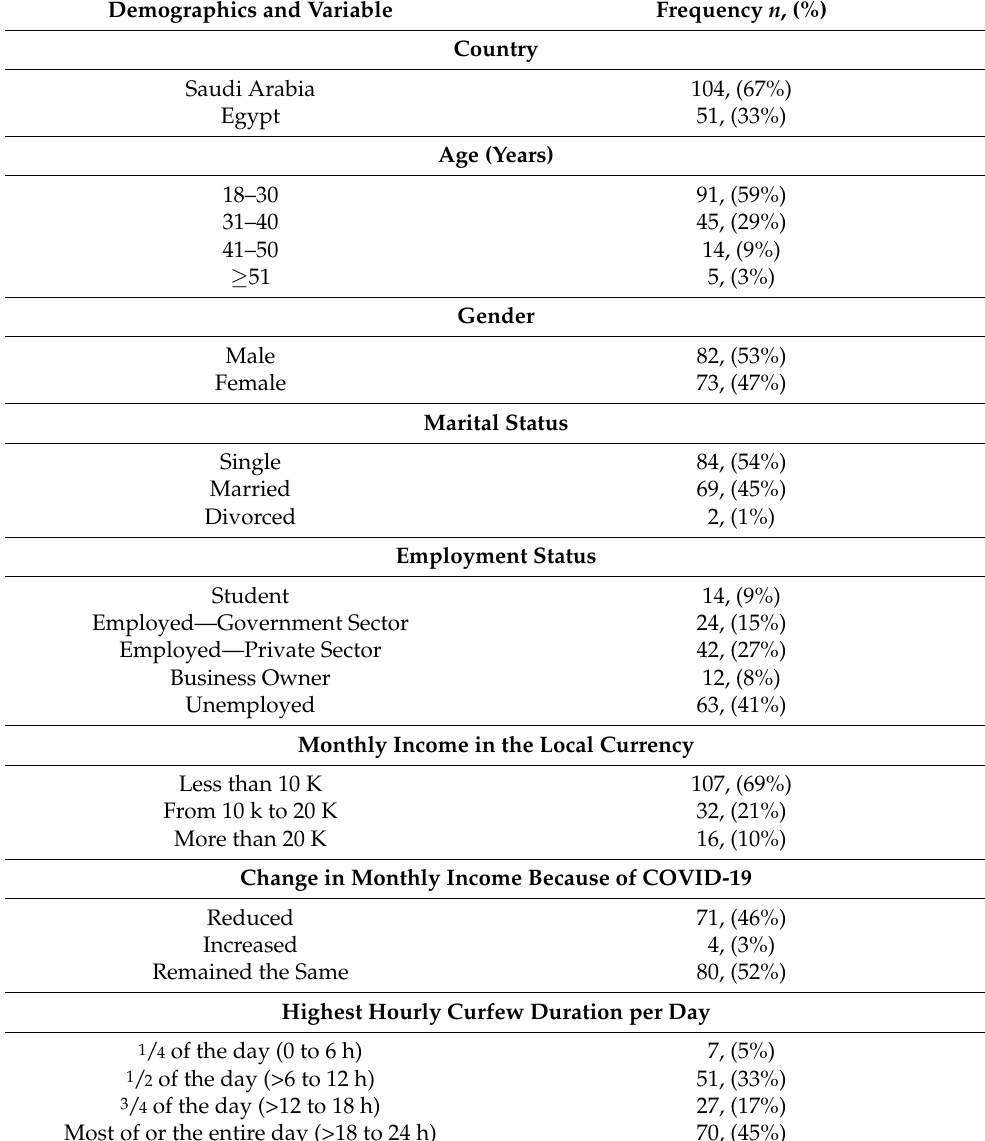
Table 1. Respondent demographics ( n = 155 for each